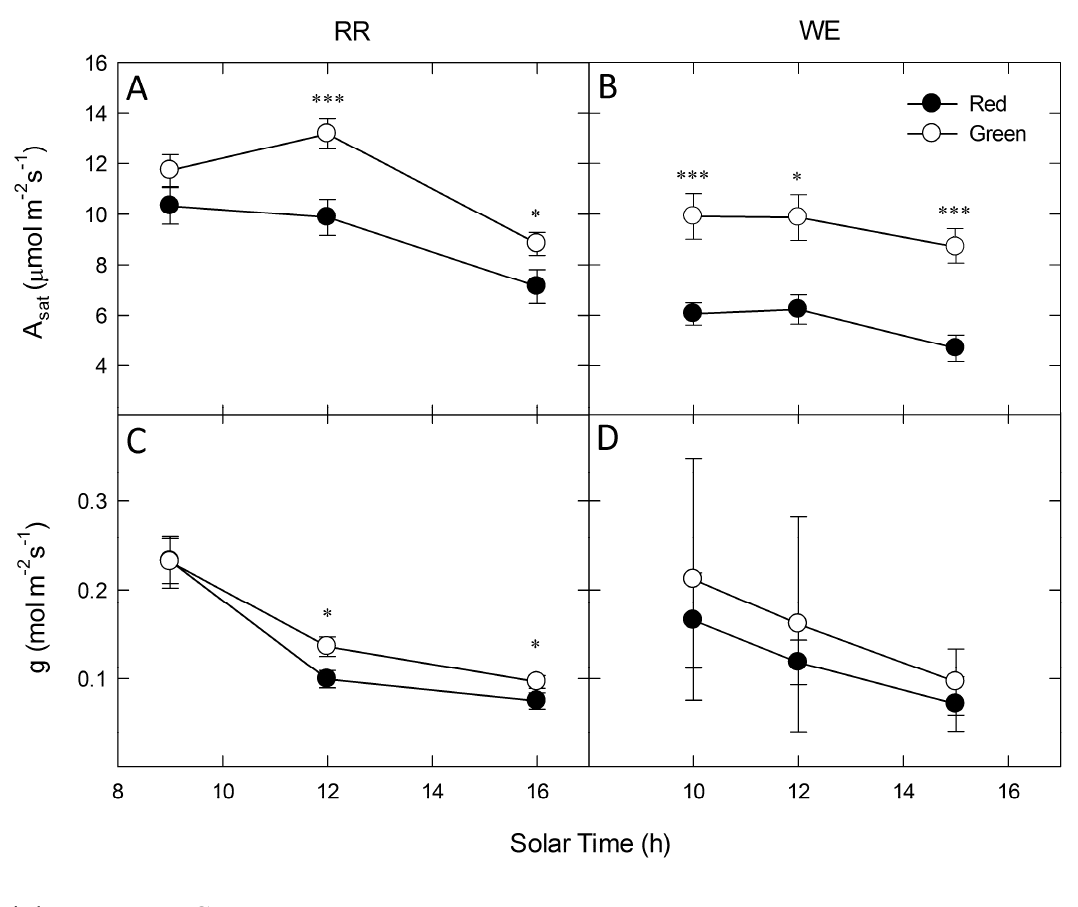
(closed circles) and green leaves (open circles) under saturating red/blue LED irradiance. Panels ( A ) and ( B ) show photosynthesis at saturating irradiance (A sat ) and ( C ) and ( D ) show stomatal conductance (g) at RR (left column) and WE (right column). Points represent means of 3–15 individuals of each color ± SE. Significant differences between red and green leaves at each time point denoted by asterisks (* p < 0.05; ** p < 0.01, *** p <